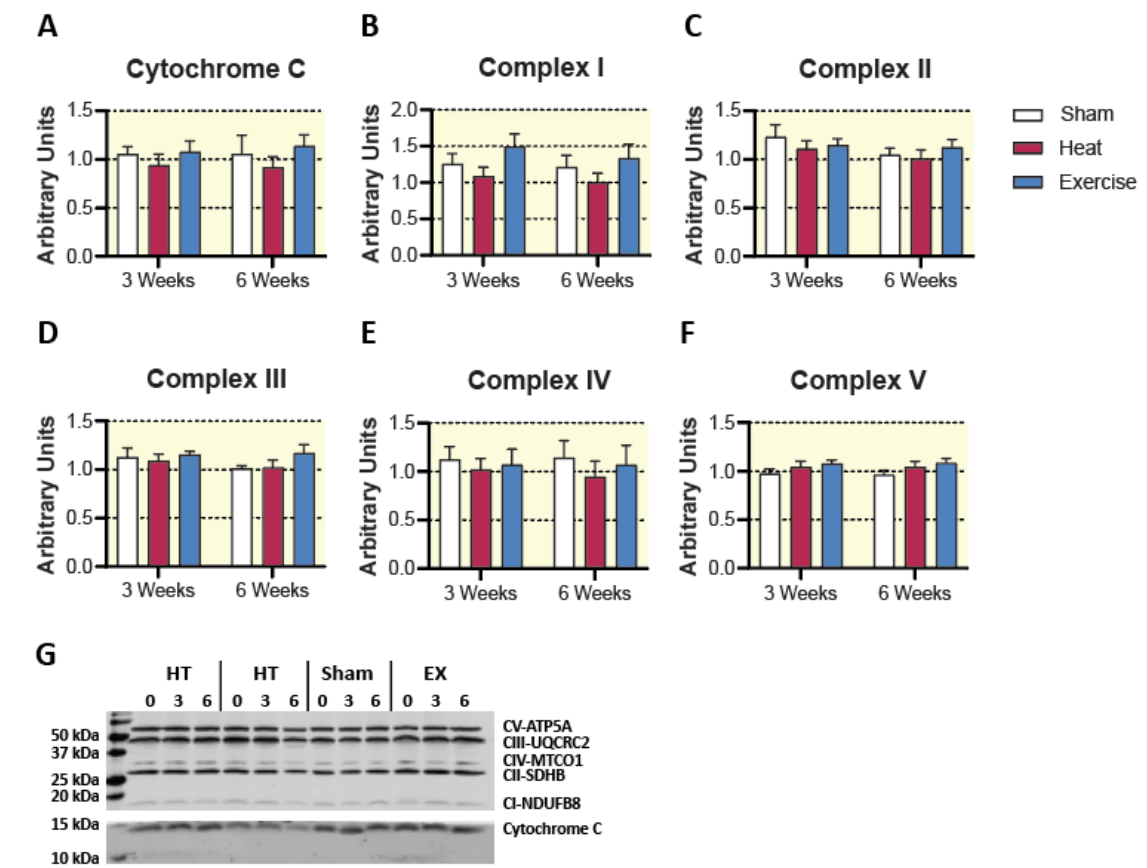
Figure 3. Mitochondrial protein content assessed by Western blot. ( A – F ) All individual values are reported as a fold change from their own baseline measure. Results are represented as mean ± SEM ( n = 8–10). ( G ) Representative blots.